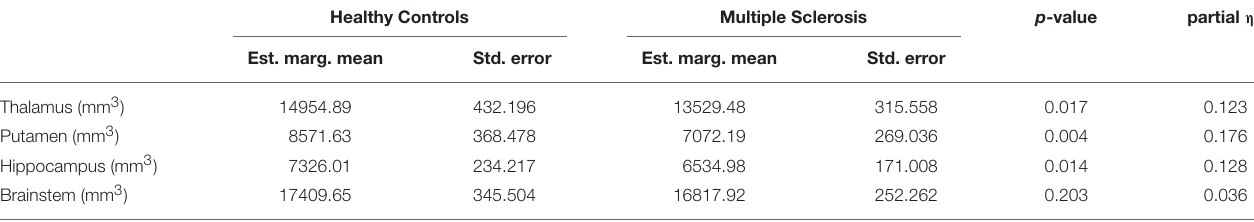
TABLE 2 | The volumetric profile of subcortical gray matter structures and the brainstem in MS patients and controls. Healthy Controls